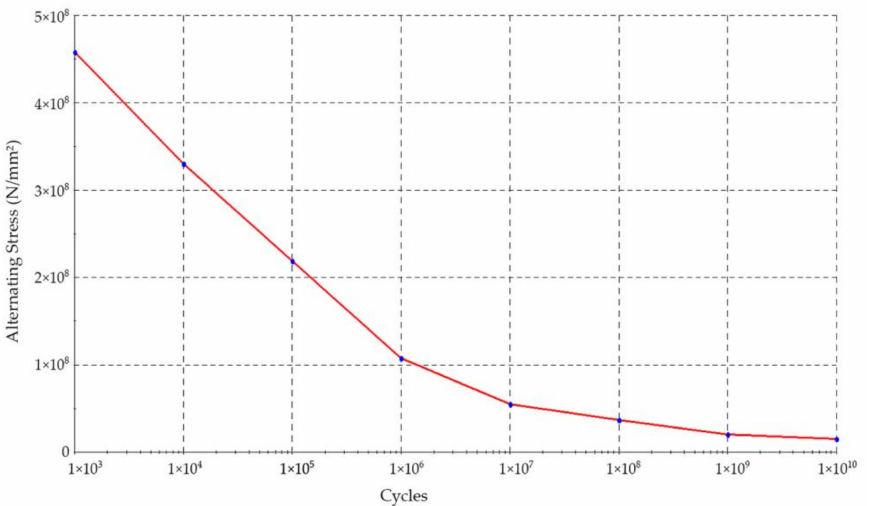
Figure 24. S–N curve defined in SOLIDWORKS. This experimental validation is presented in detail in [63] where the results of strain gauge measurements are compared with FEM analysis performed on a BWE working in similar